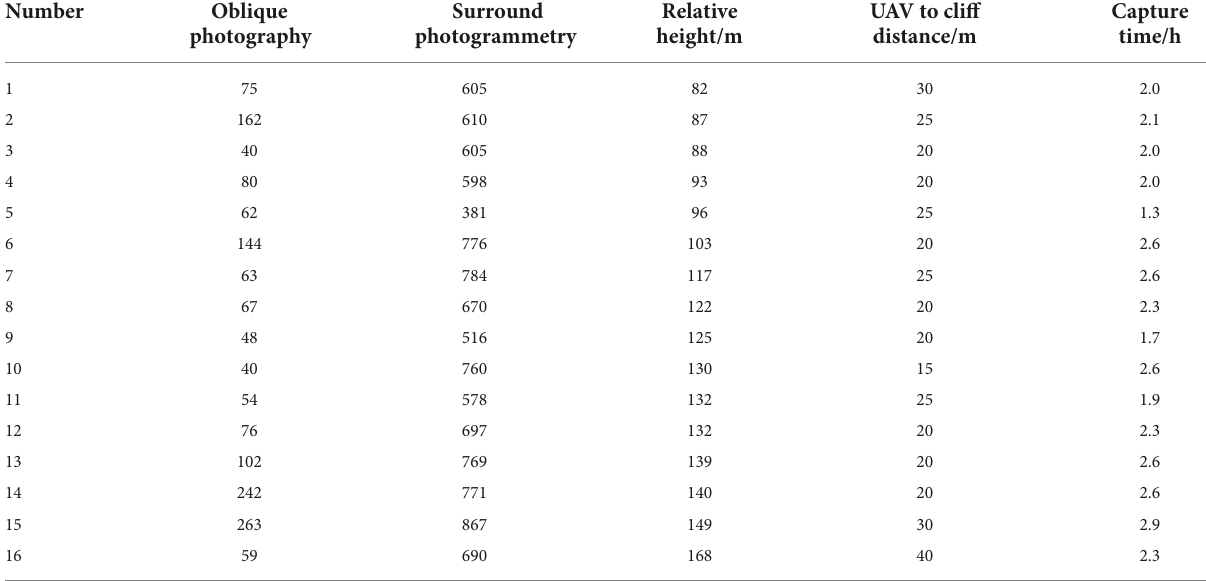
TABLE 2 Specifications of the produced unmanned aerial vehicle (UAV)